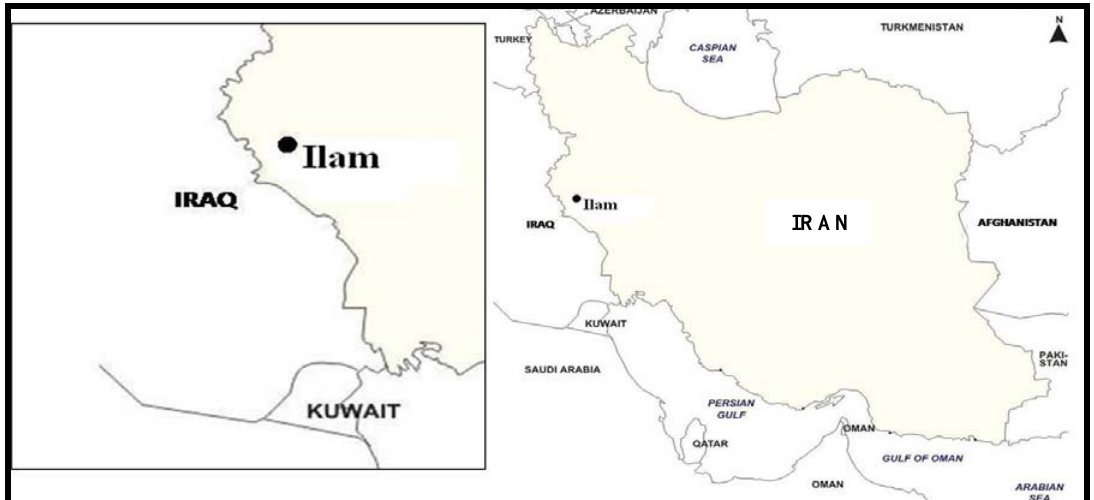
F IGURE 1. Sampling locality of A. euphratica (Ilam).